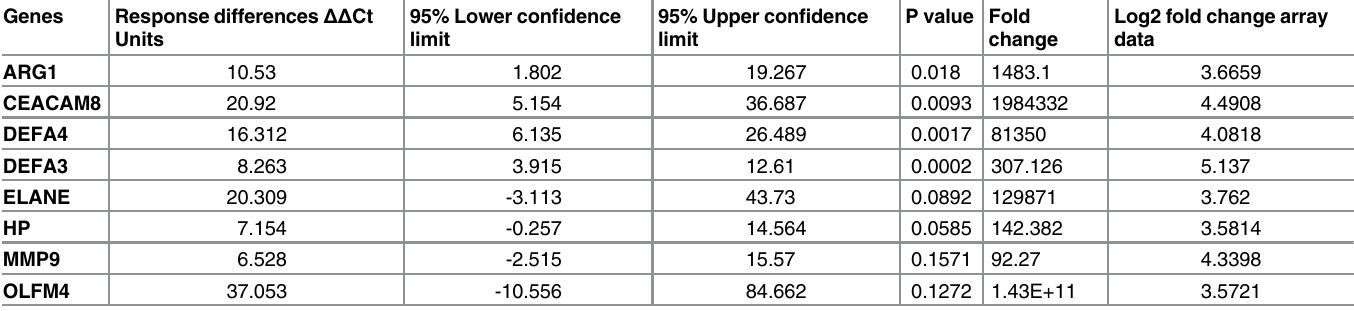
Table 5. Results from QPCR of the target genes in breast cancer patients treated with DOX-based chempotherapy who developed abnromal decline in LVEF after the completion of chemotherapy. Genes Response differences ΔΔ Ct